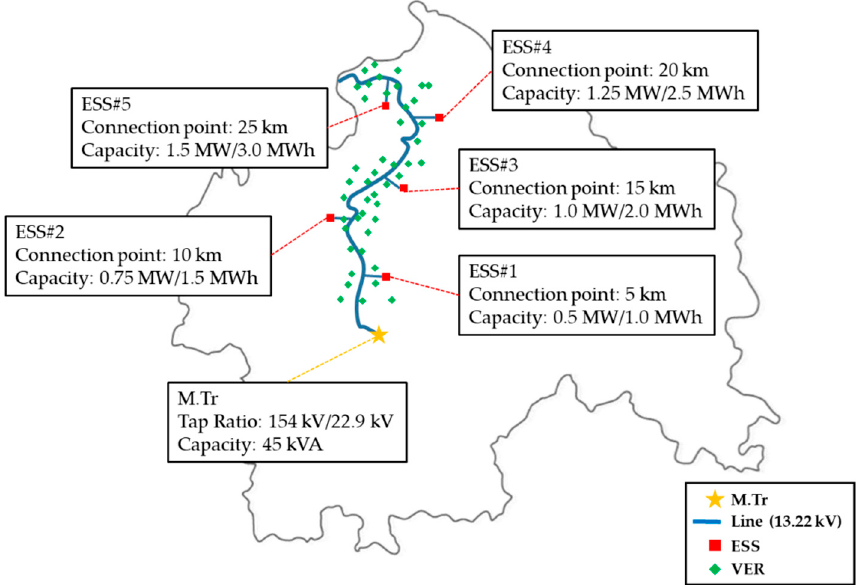
Figure 8. Distribution system model.